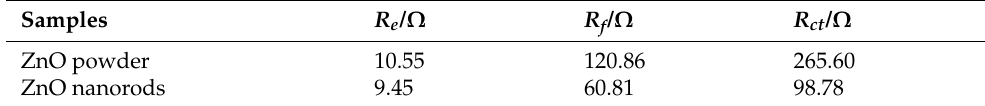
Figure 12. Electrochemical impedance spectroscopy plots of the Zn/KOH/Ag 2 O battery, ZnO nanorods electrodes, with 10 mHz to 100 kHz, amplitude 5 mV and at an open circuit voltage of 1.55 V. Table 4. Impedance parameters calculated from equivalent